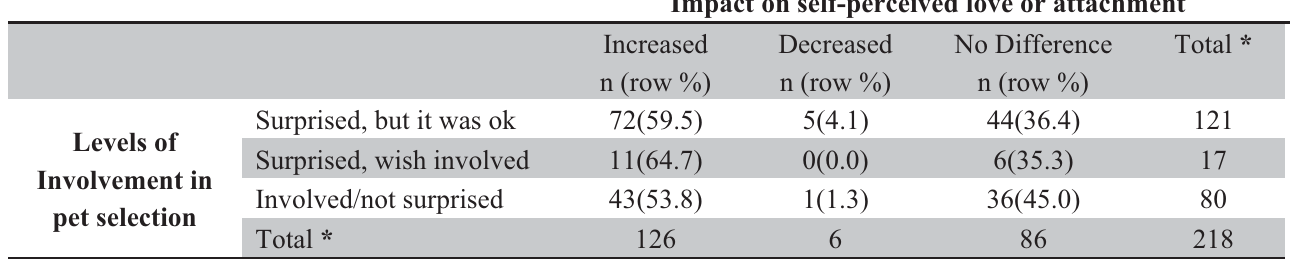
Table 1. Frequencies of the impact receiving a gift has on self-perceived love or attachment. * Response choices: Refused, Don’t Know and Other are excluded.